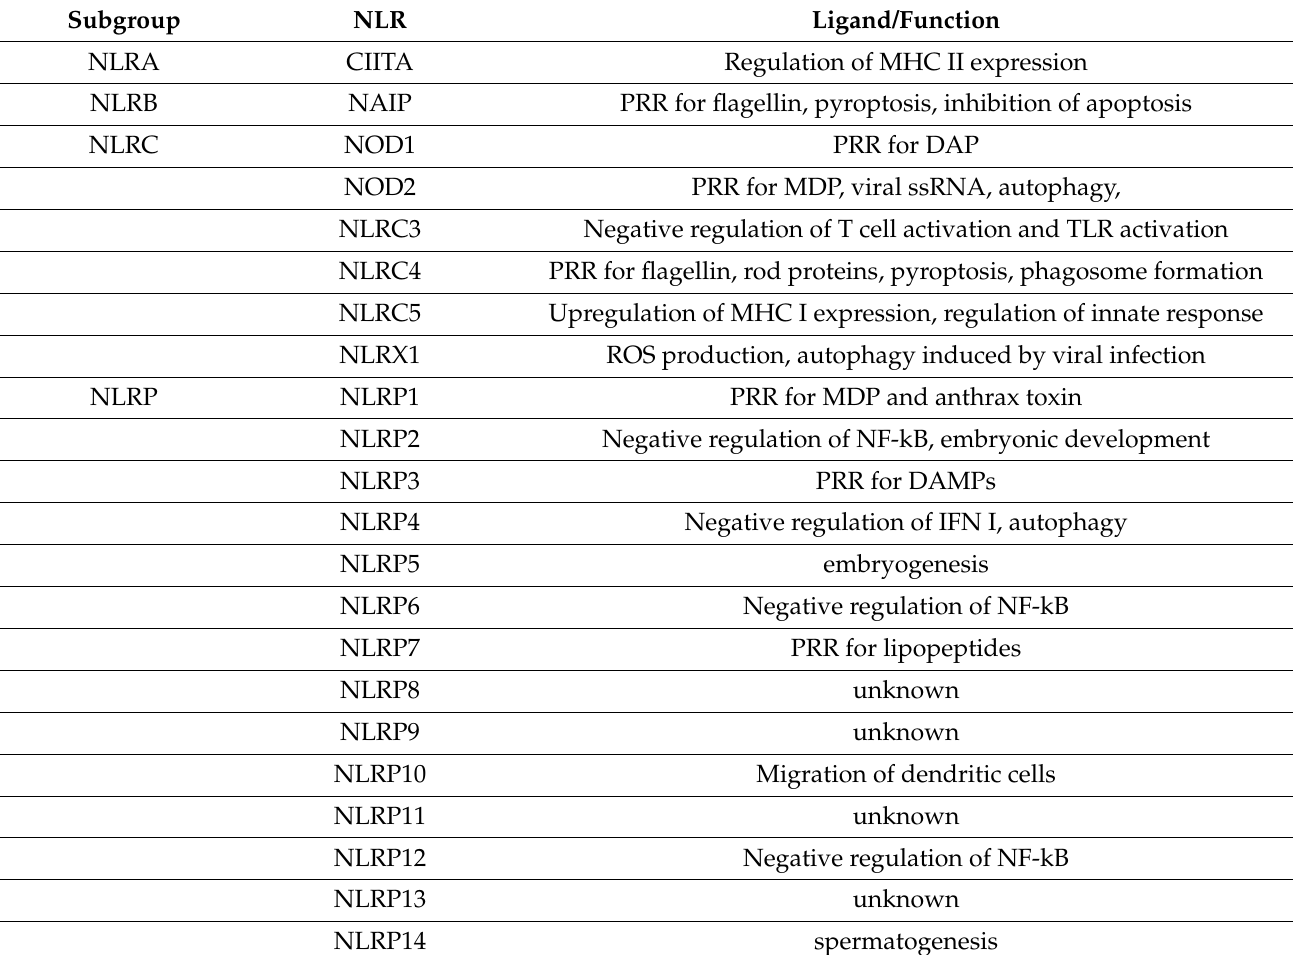
Table 2. Receptor ligands for NLRs and their functions in the body [84,102]. PRR-pattern recognition receptors, DAP- diaminopimelic acid, MDP-muramyl dipeptide, ROS-reactive oxygen species, and DAMPs-damage associated molecu- lar